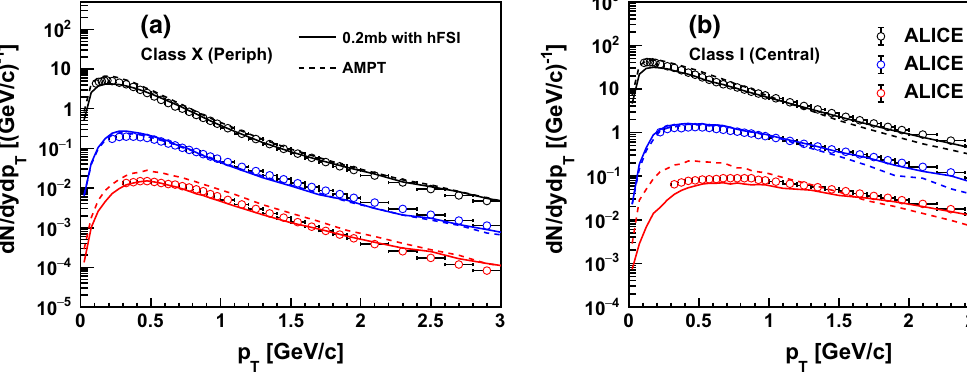
Fig. 8 Transverse momentum spectra with | y | < 0 . 5 for π (black), K (blue) and proton (red) in event class X for peripheral collisions (left) and event class I for central collisions (right) compared to AMPT calcu-